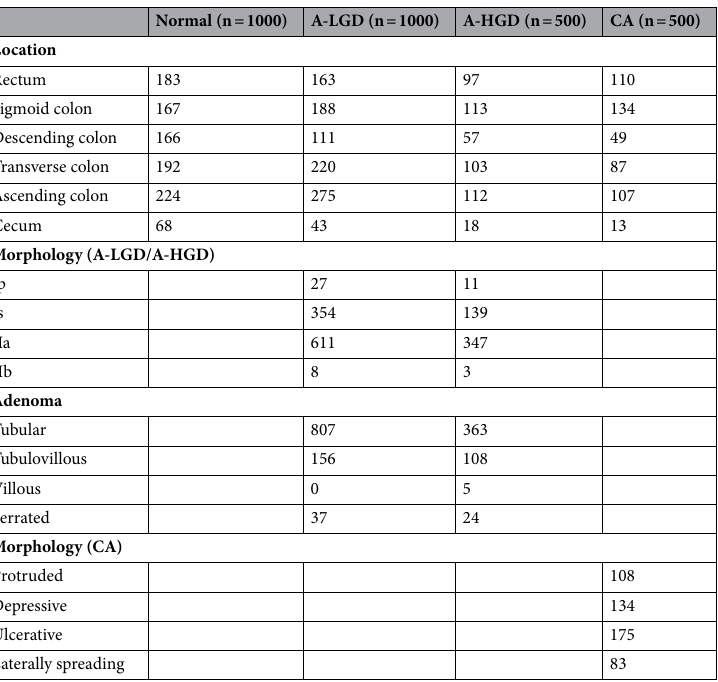
Table 1. Characteristics of colonoscopic images. CA adenocarcinoma, A-HGD adenoma with high grade dysplasia, A-LGD adenoma with low grade